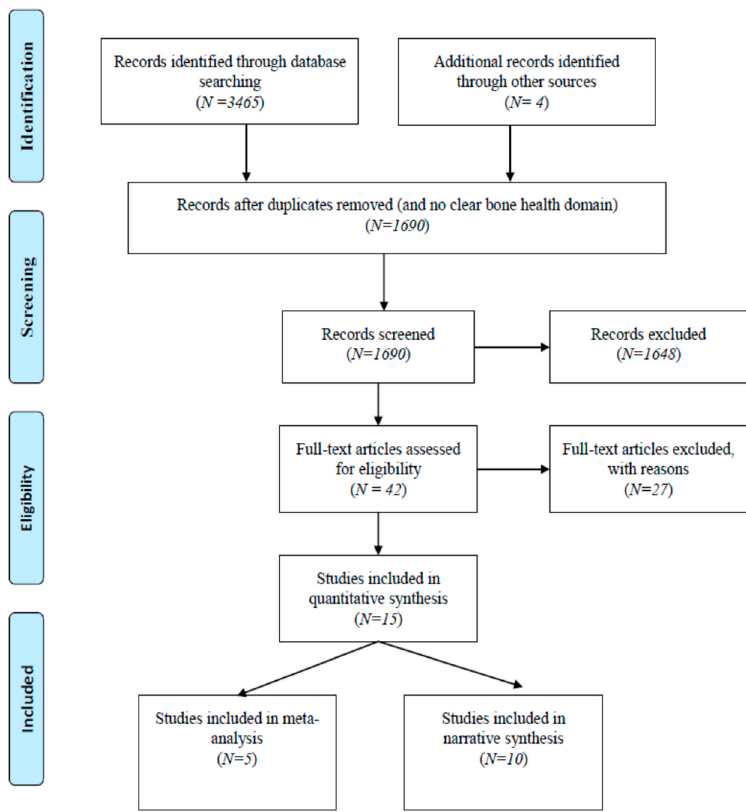
Figure 1. Preferred Reporting Items for Systematic Reviews and Meta-analyses (PRISMA)